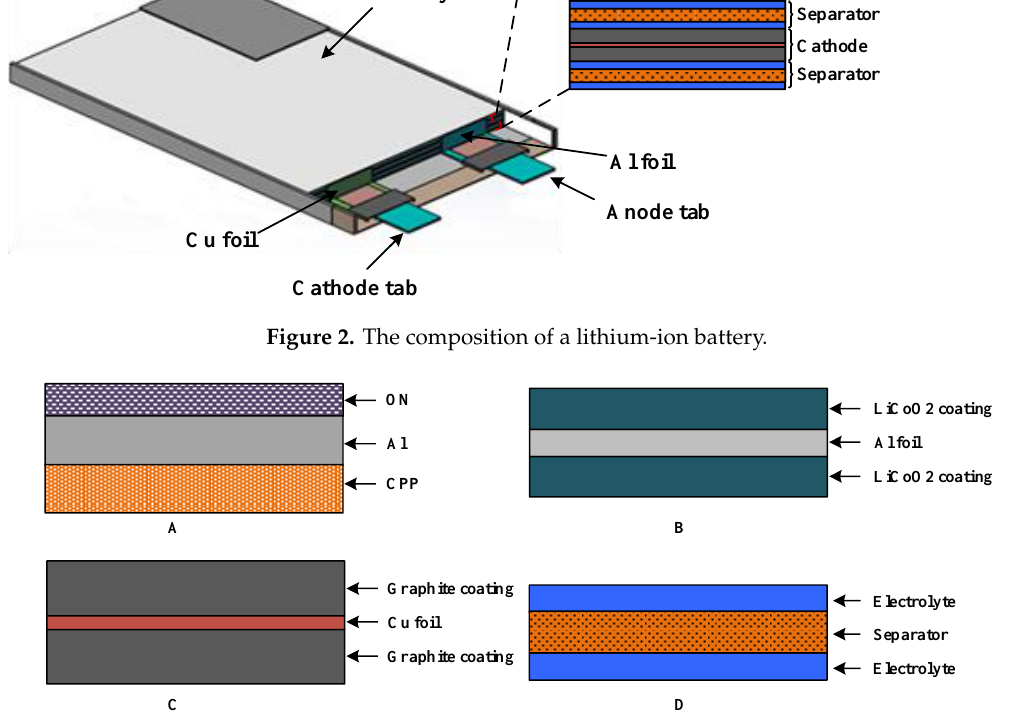
Figure 3. The schematic diagram of the composition unit structure of a lithium-ion battery ( A ) The schematic diagram of Al-plastic film; ( B ) The schematic diagram of anode electrode plate; ( C ) The schematic diagram of cathode electrode plate; ( D ) The schematic diagram of separator.